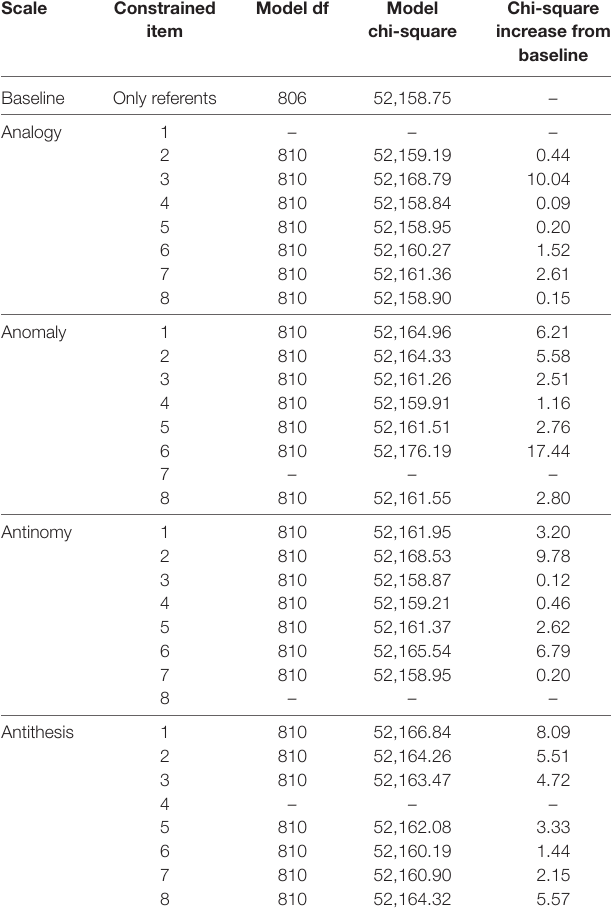
taBlE 2 | Likelihood-ratio tests for differential item functioning between males and females.